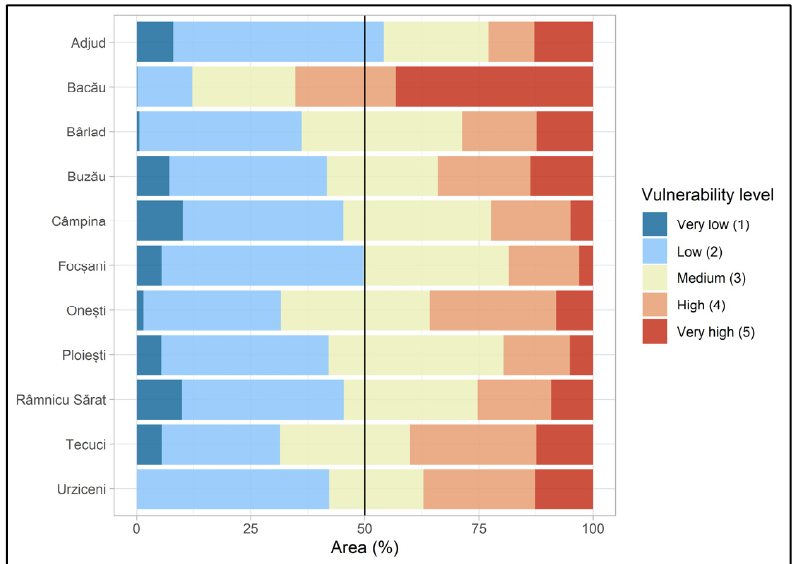
Figure 7. Areas (as percentage of urban territory) of systemic vulnerability levels, in the 11 urban settlements. 11 urban